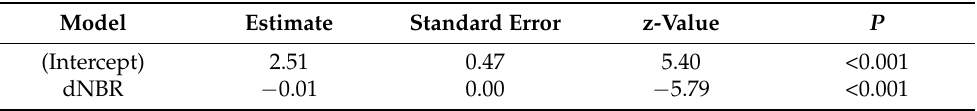
Table A4. Hurdle regression model results for fire severity-post-fire woody plant regeneration in Chiricahua National Monument, Arizona, USA. Post-fire regeneration was significantly negatively influenced by fire severity (dNBR) for all species lumped (shown below), and for individual tree species (data not shown) @ p <